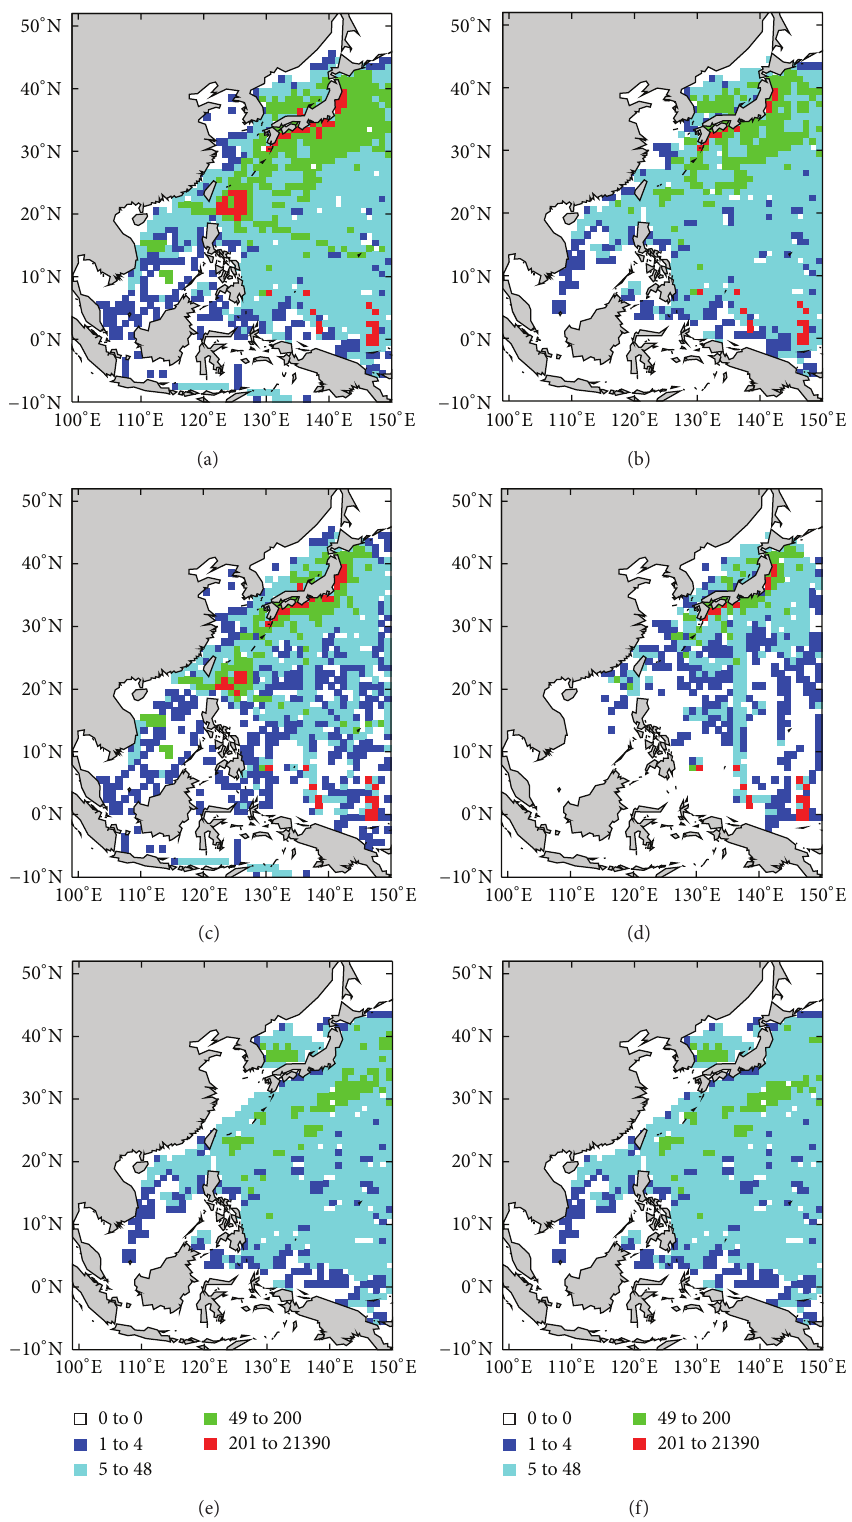
Figure 1: Distributions of “observations” used in reanalysis twin experiments from January 2005 to December 2008: (a), (c), and (e) are temperature “observations”; (b), (d), and (f) are salinity “observations.” (a) and (b) are for all “observations”; (c) and (d) “conventional observations”; (e) and (f) “Argo observations.” Color square represents the number of